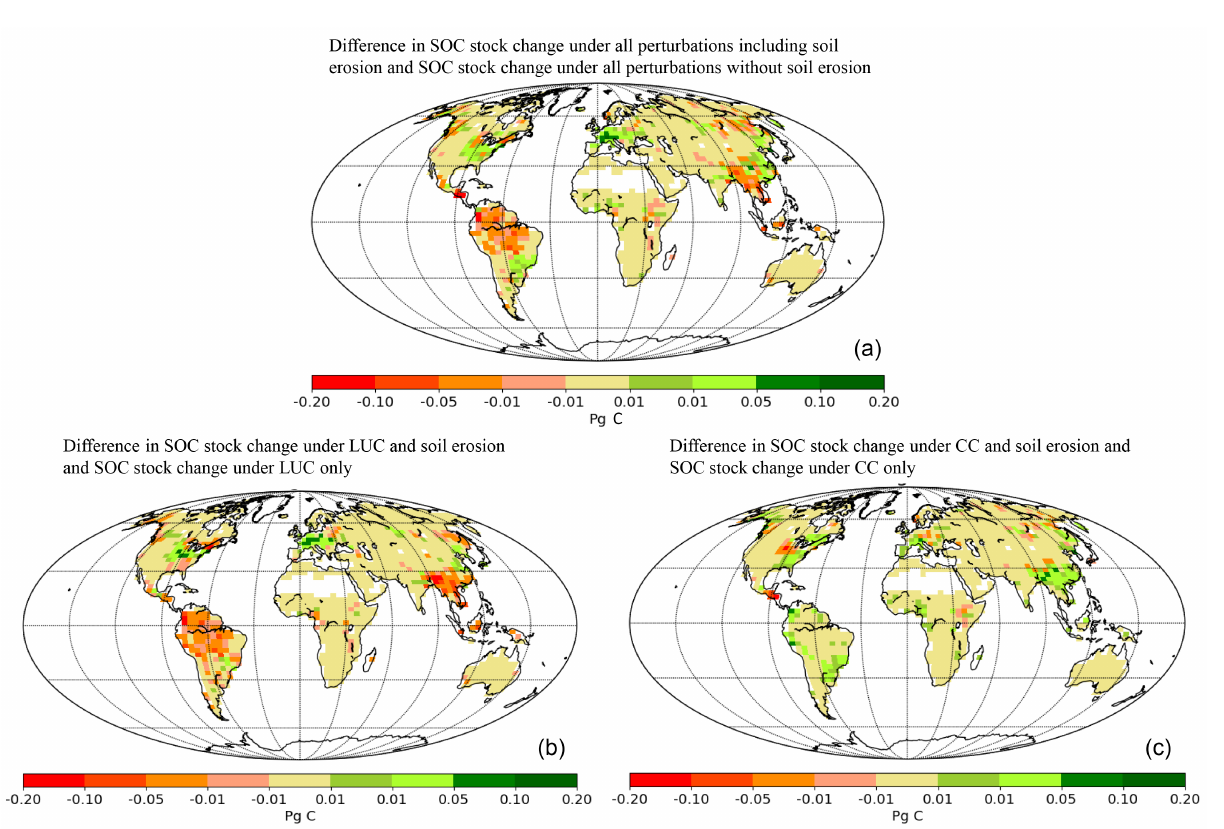
Figure 8. (a) Difference between the changes in SOC stocks over the period 1850–2005 under all perturbations including soil erosion and the changes in SOC stocks excluding soil erosion, S1–S3; (b) difference between the changes in SOC stocks under LUC including soil erosion and the changes in SOC stocks excluding soil erosion, S1–S2 to S3–S4; (c) difference between the changes in SOC stocks under a variable climate and CO 2 increase including soil erosion and the changes in SOC stocks excluding soil erosion, S2–S4.